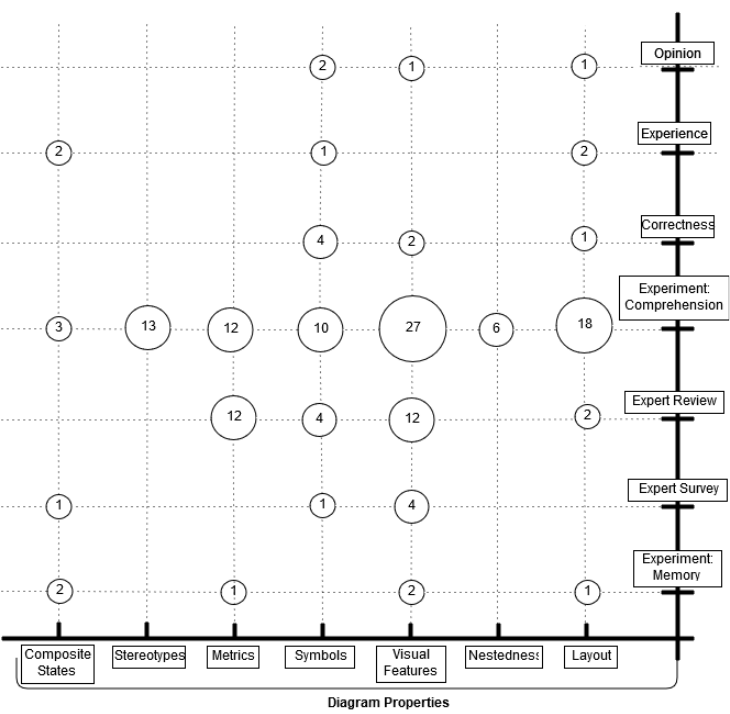
Figure 2. Model properties concerned by specific research